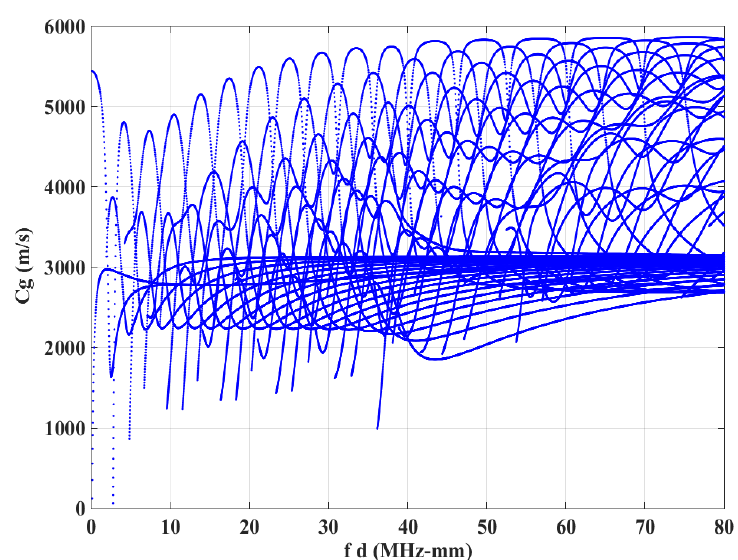
Figure 4. Group velocity dispersion curves of isotropic steel plate. Table 2. Parameters of mode pairs.